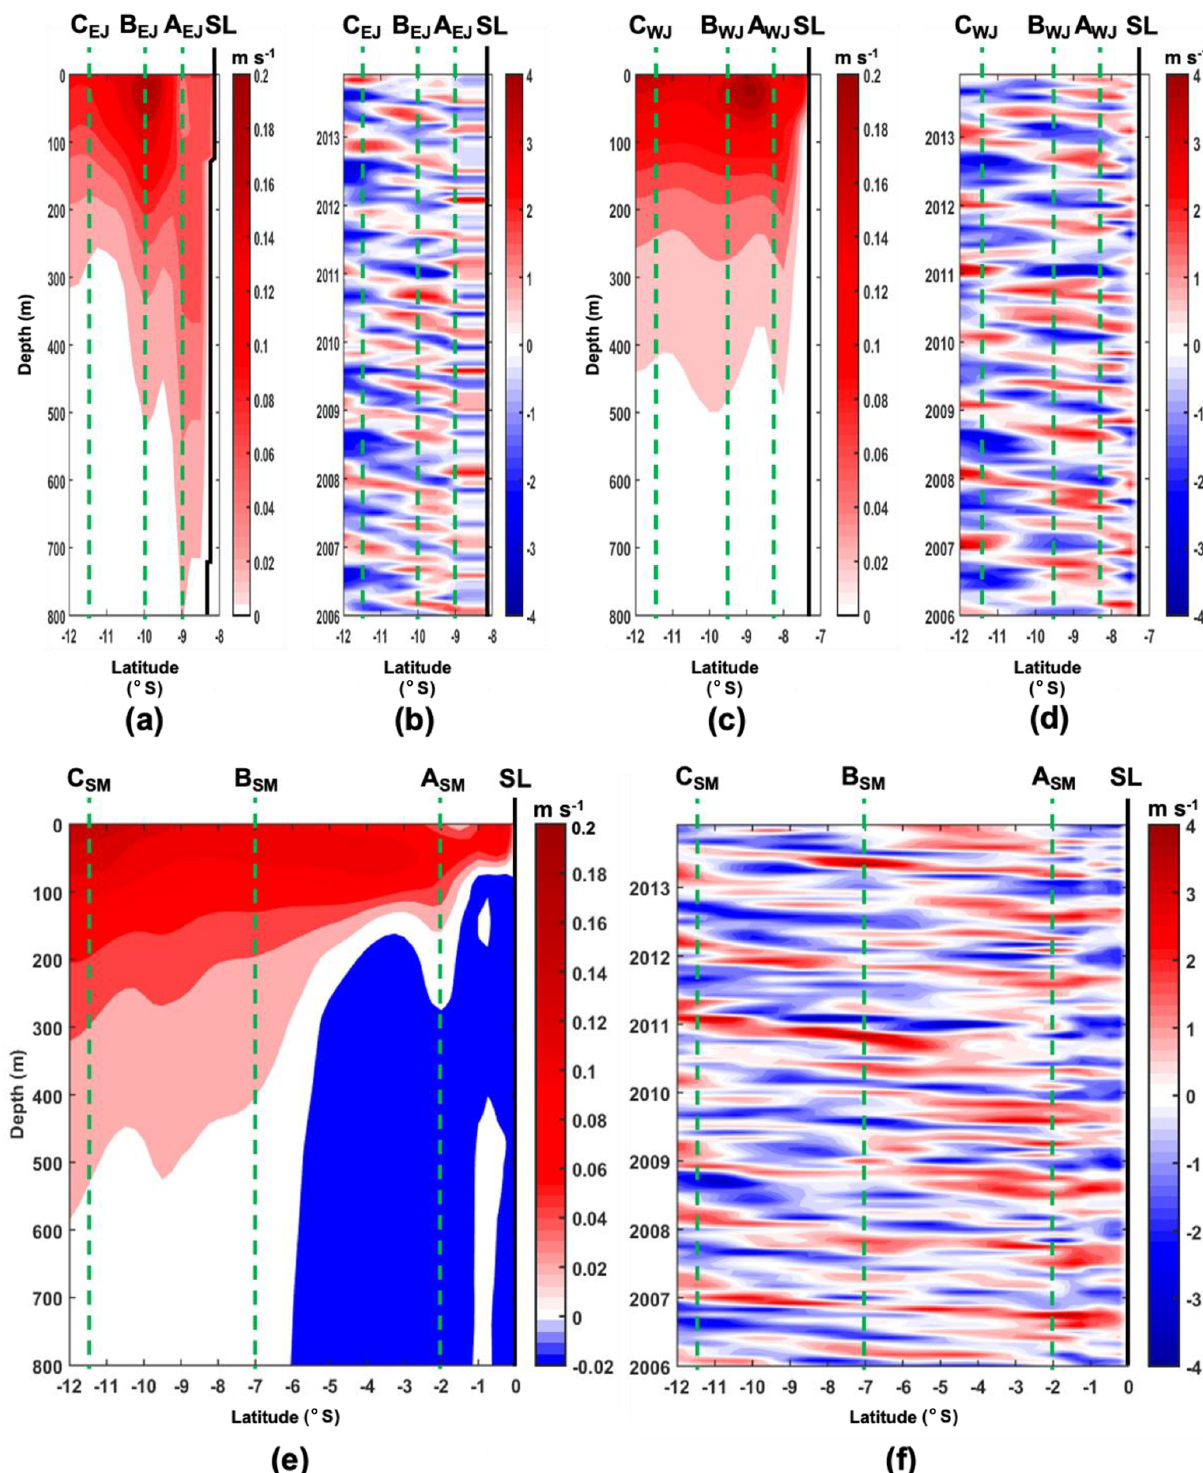
Figure 9. Vertical mode structures (a, c, e) and their associated temporal variability of EOF1 (b, d, f) for zonal currents relative to the mean flow along the three meridional sections: EJ (a, b) , WJ (c, d) , and SM (e, f) . In this case, the temporal variability is shown for the last 8-year period of the EOF1. The direction of mode velocities relative to the mean flow is determined by multiplying the sign of the vertical mode structure and the sign of the temporal mode variability. Positive (negative) values of the velocity variability relative to the mean flow indicate eastward (westward) flow. Meanwhile, dashed green lines indicate the latitudes of the nine analyzed points, and SL stands for